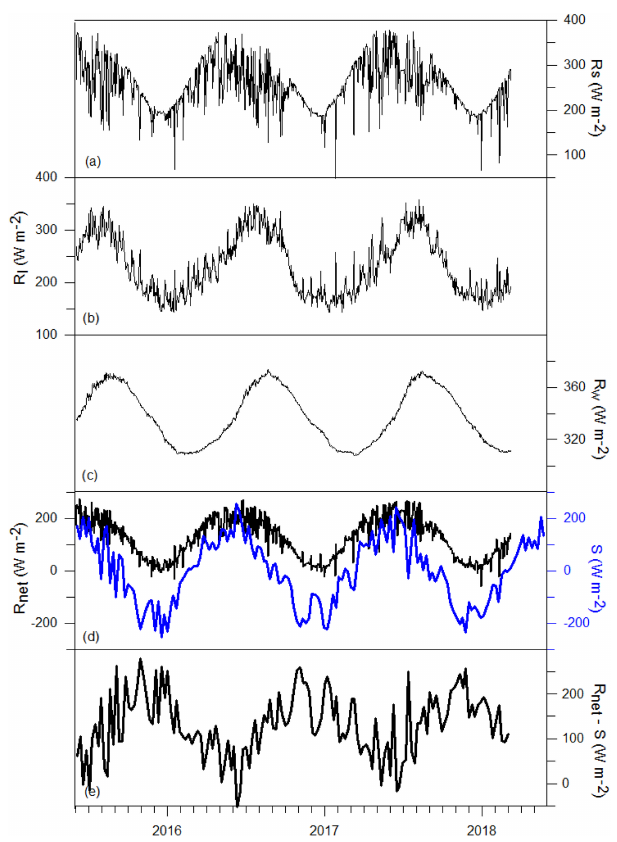
Figure 4. The main components of energy budget at the lake sur- face. (a) Daily solar radiation ( R s ), (b) daily atmospheric longwave radiation to the lake ( R l ), (c) daily longwave radiation emitted from the lake ( R w ), (d) daily net radiation ( R net ) and weekly changes in lake heat storage ( S ), and (e) the available energy ( R net − S ).